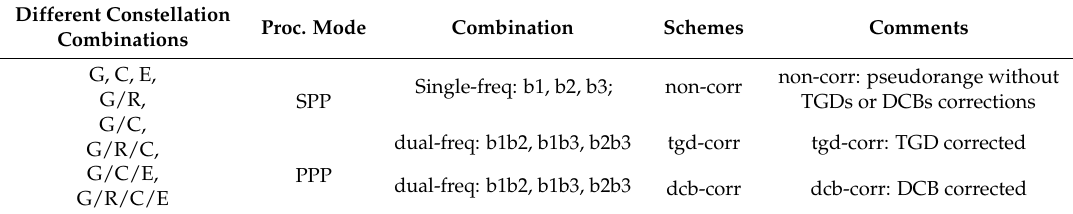
Figure 1. The distribution of stations from MGEX.